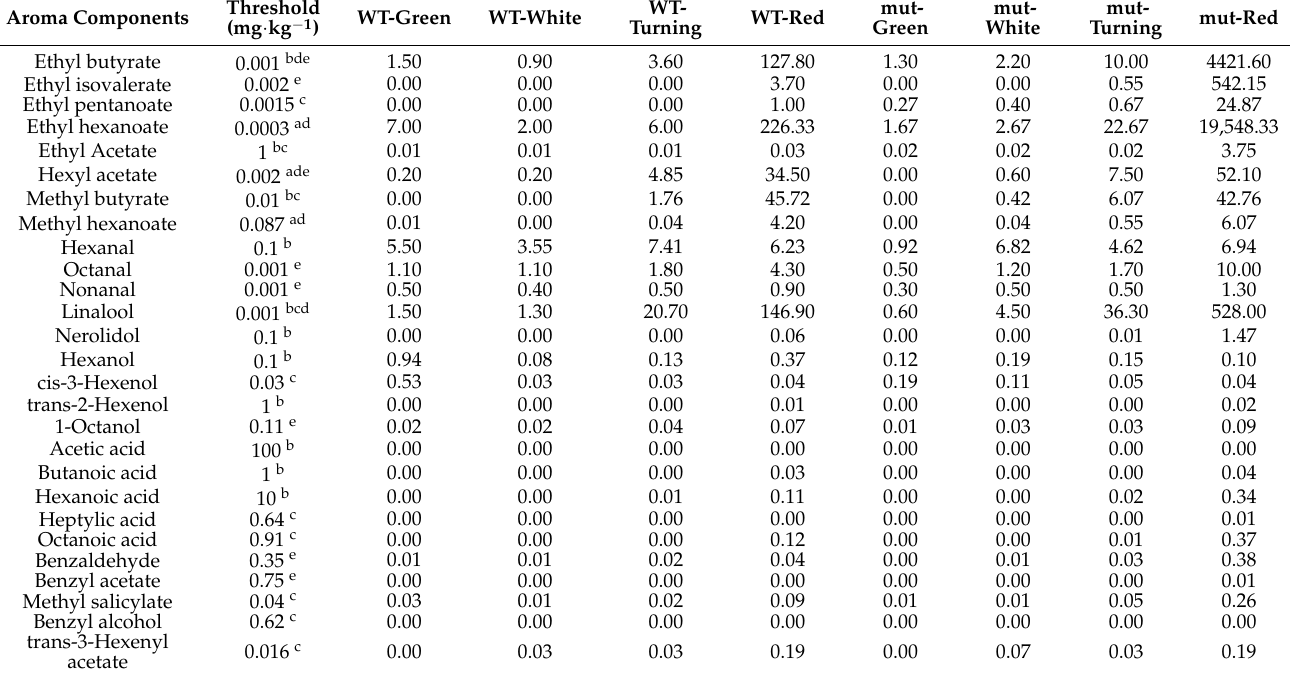
Table 1. Odor activity values (OAVs) of selected aroma compounds in ‘Benihoppe’ and